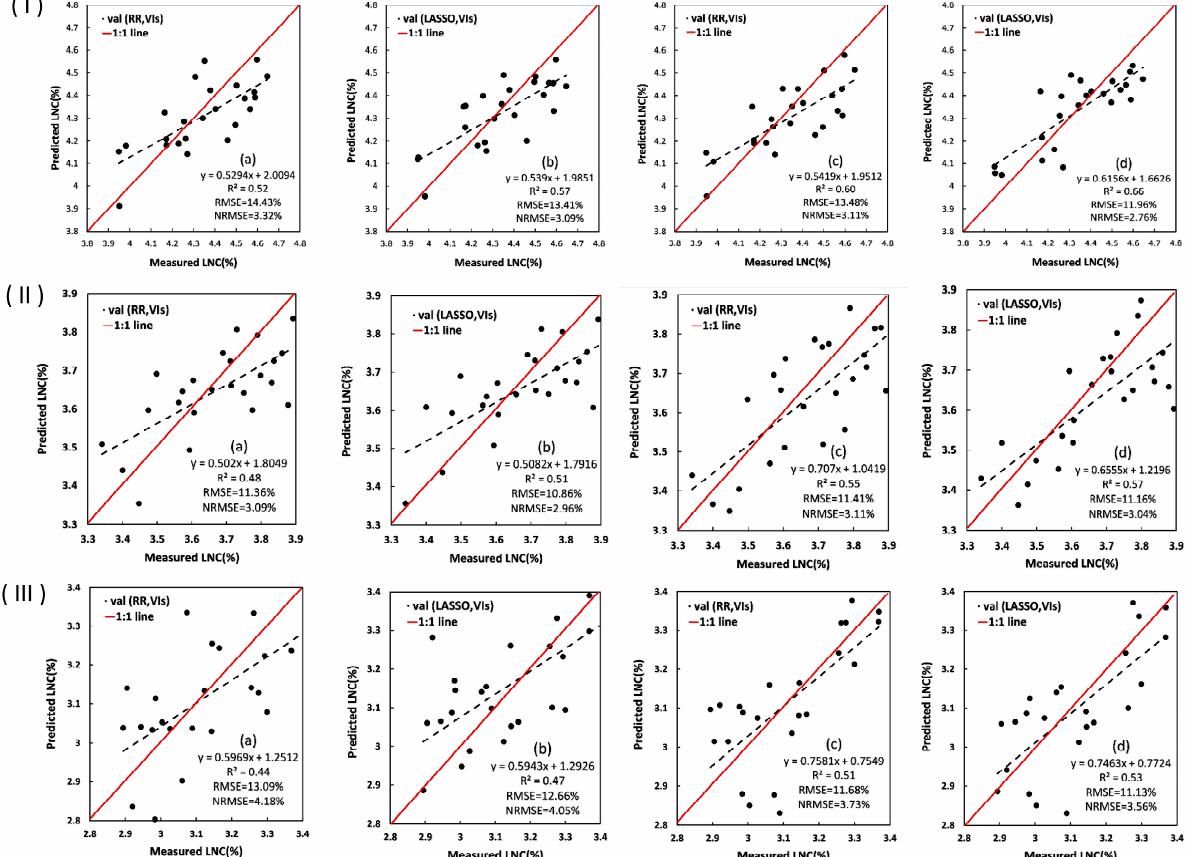
Figure 11. Predictive performance for each stage. ( I – III ) represent the Rice Jointing, Booting and Filling stage, respectively. ( a ) Using RIDGE Regression for original multispectral images; ( b ) Using LASSO Regression for original multispectral images; ( c ) Using RIDGE Regression for fusion images; ( d ) Using LASSO Regression for fusion images.